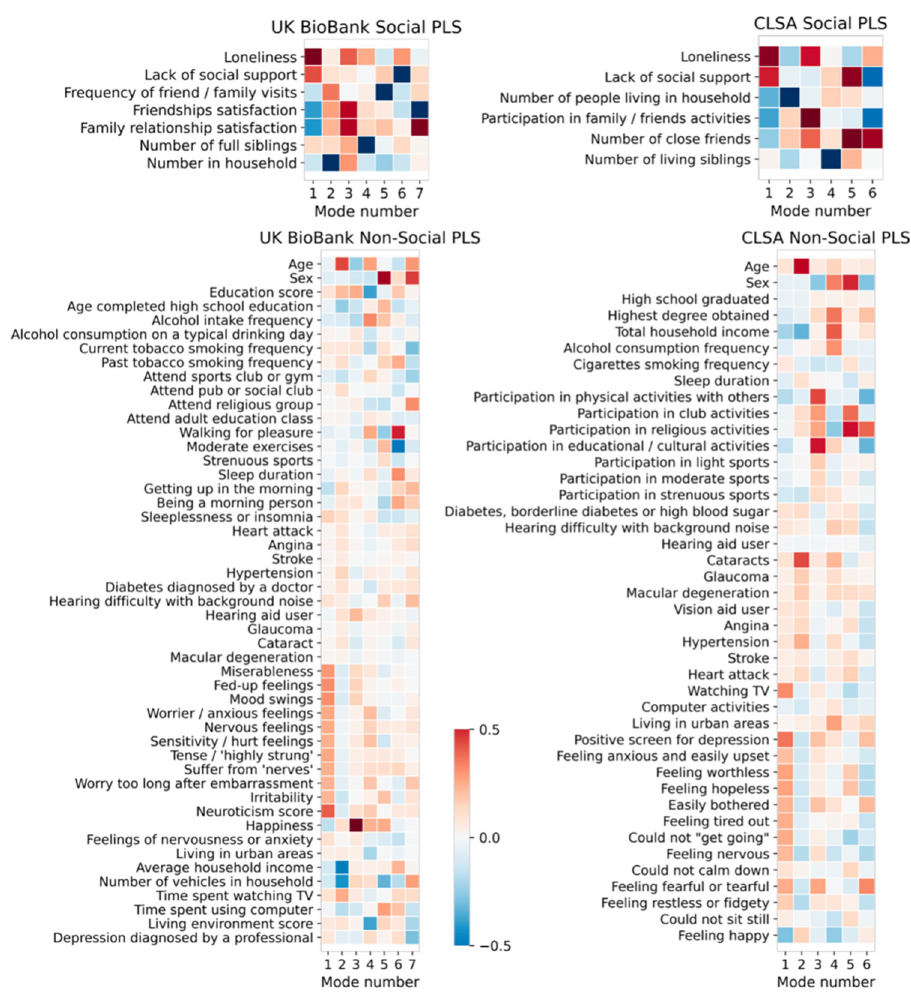
Fig 1. Widespread cross-associations exist between social deprivation indicators and traditional risk factors for Alzheimer’s dementias. To gain a synoptic overview, we initially explored multivariable relationships between sets of social richness measures (top row) and sets of usually studied aetiopathological risk factors (lower row). In 502,506 UK Biobank participants (left column), the leading explanatory patterns (‘modes’) show that perceived and objective social isolation are associated with higher neuroticism scores and similar personality styles. In 30,097 CLSA participants (right column), the dominant pattern links loneliness and lacking social support to TV consumption and depression- related emotional traits. This doubly multivariate decomposition of two variable sets was obtained from partial least squares analysis (PLS; cf. Methods). Note that this cursory analysis does not attempt to single out special variables (in contrast to the analyses from Figs 2–5). Overall, this perspective makes apparent that the majority of examined risk factors may be related to some aspect of social